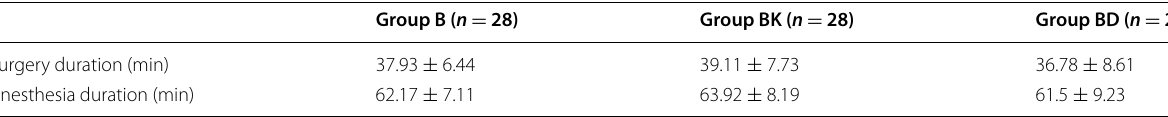
Table 3 Procedure characteristics in the study